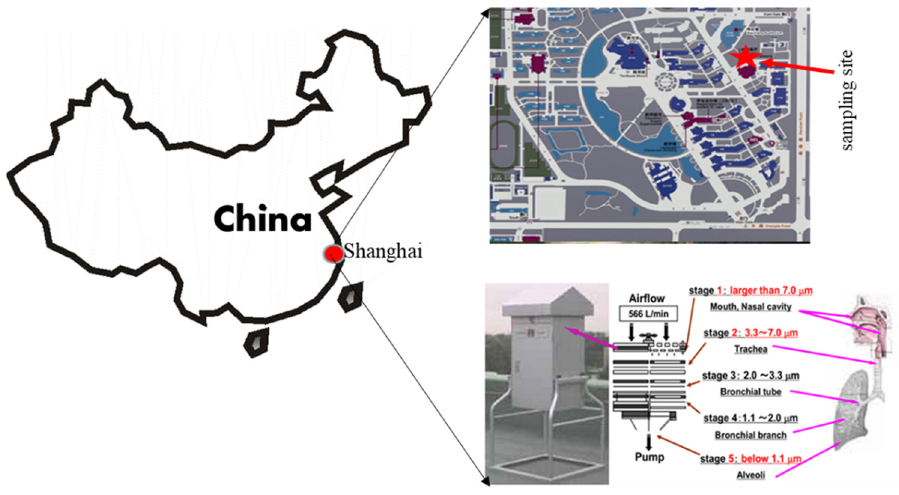
Figure 1. Sampling